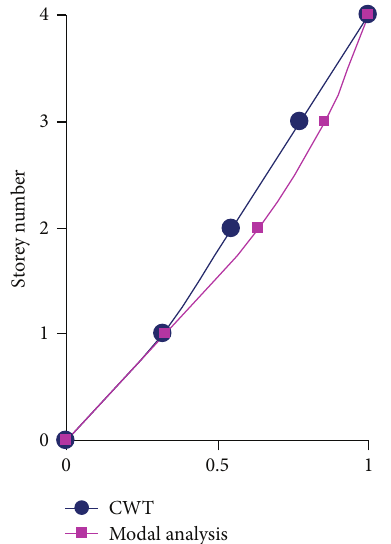
Figure 13: Time-frequency plot of modulus of CWT coefficients.